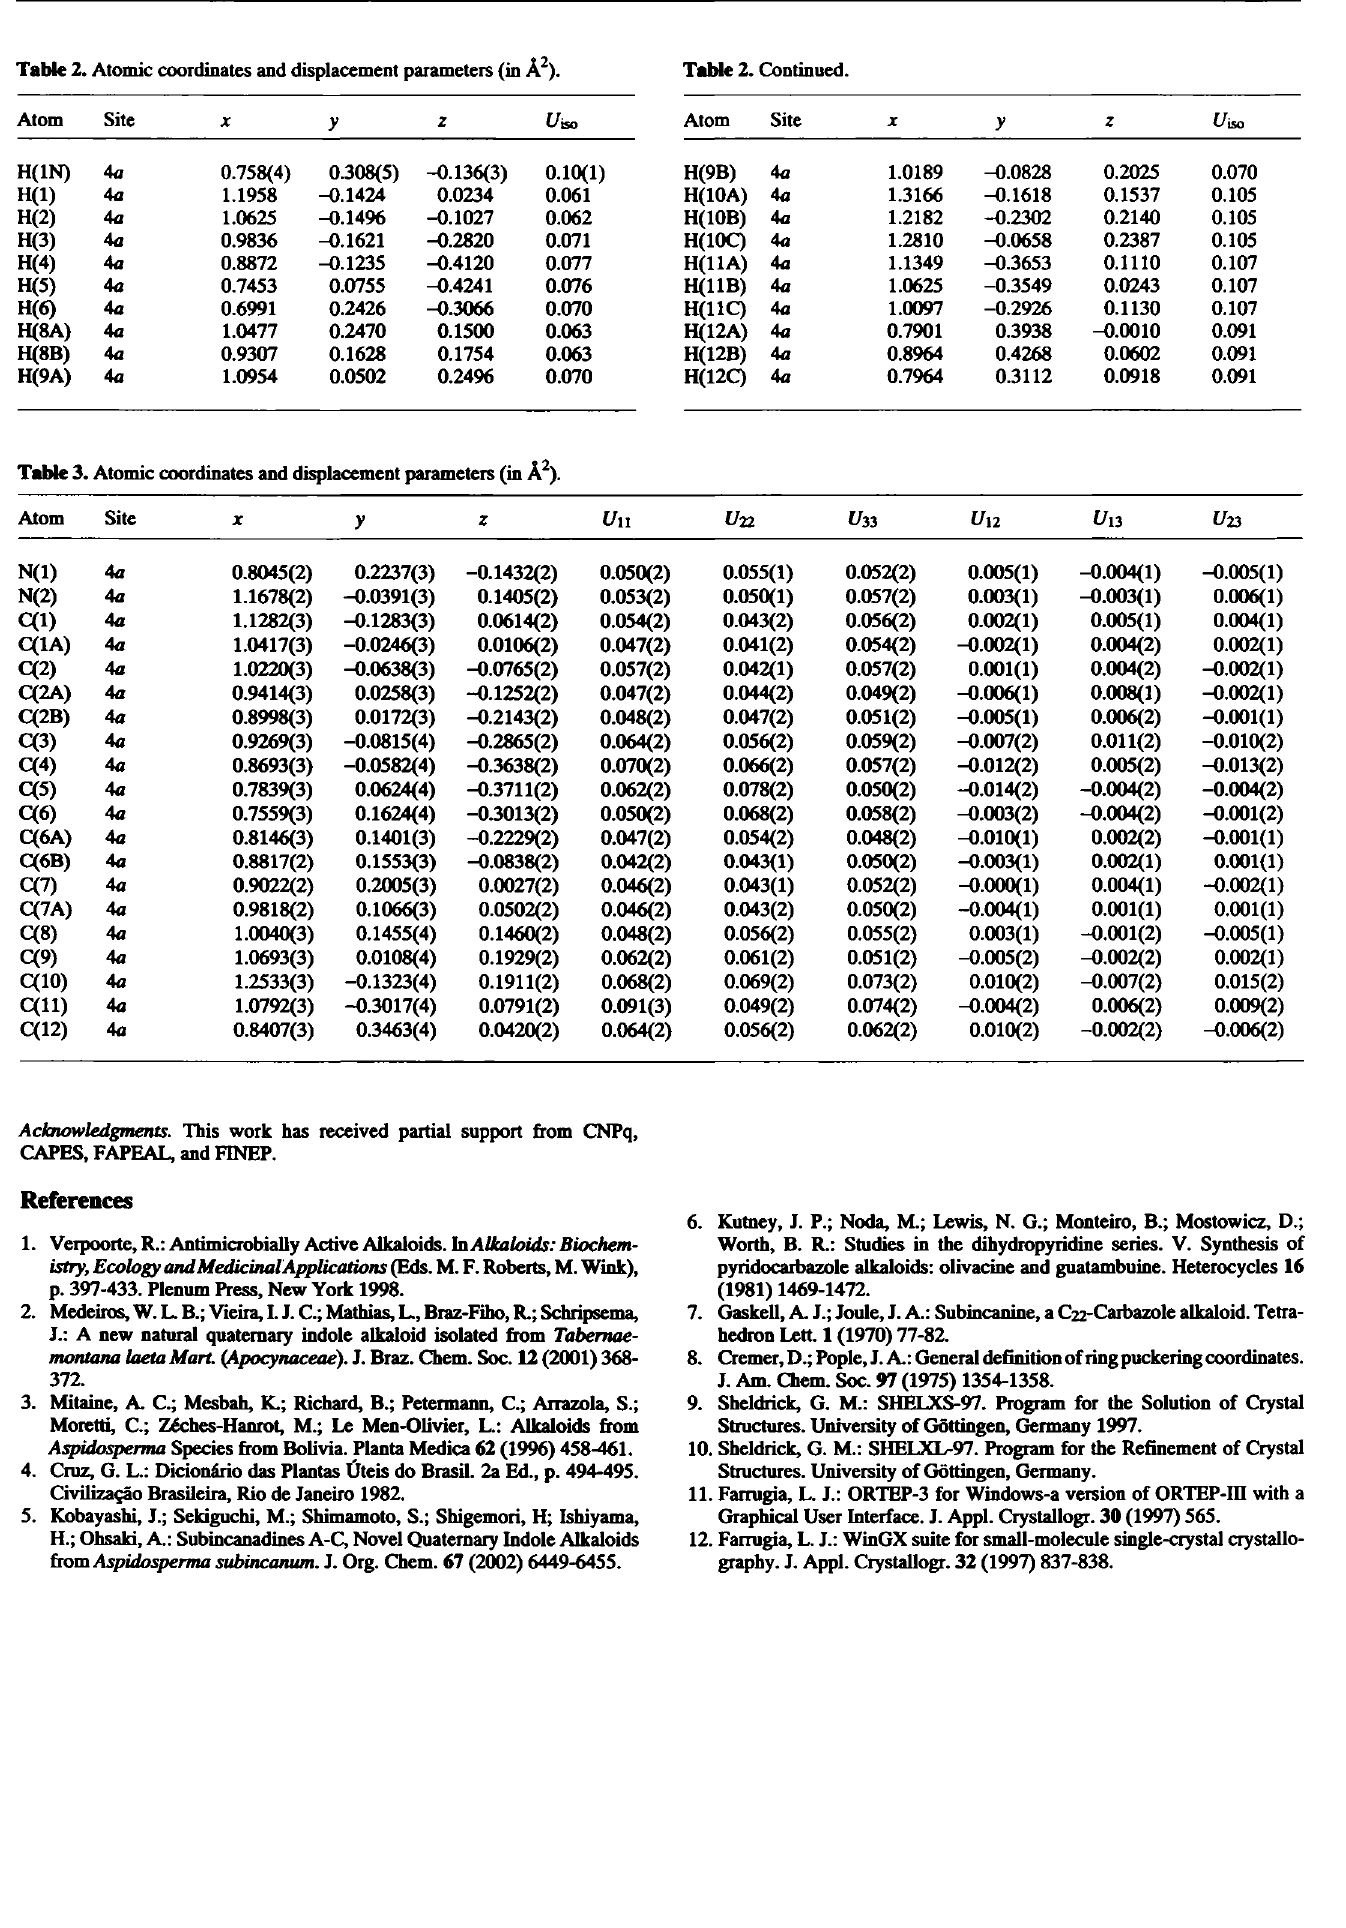
Table 3. Atomic coordinates and displacement parameters (in Ä 2